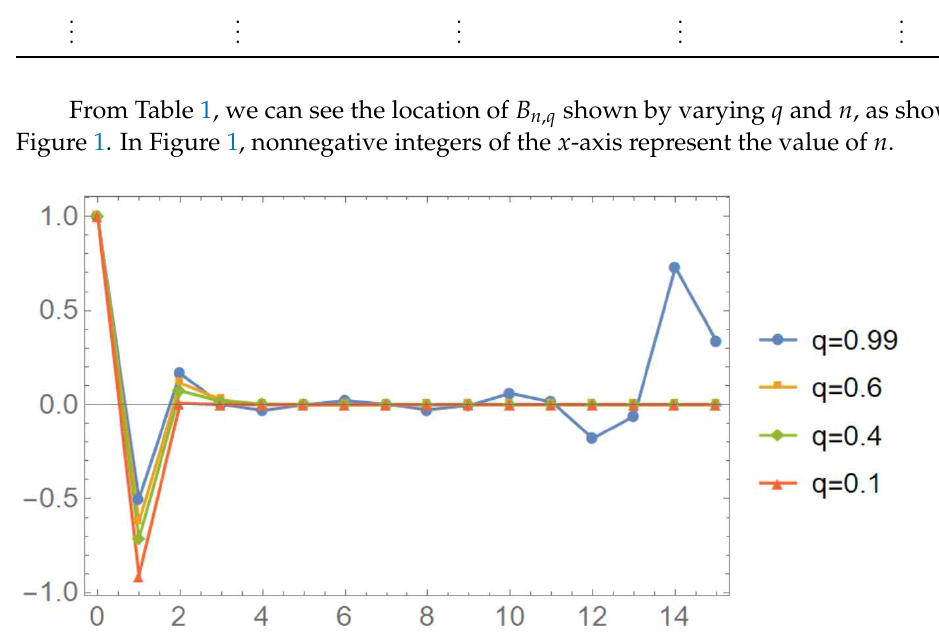
Figure 1. Locations of B n , q for 0 ≤ n ≤ 15 and q =